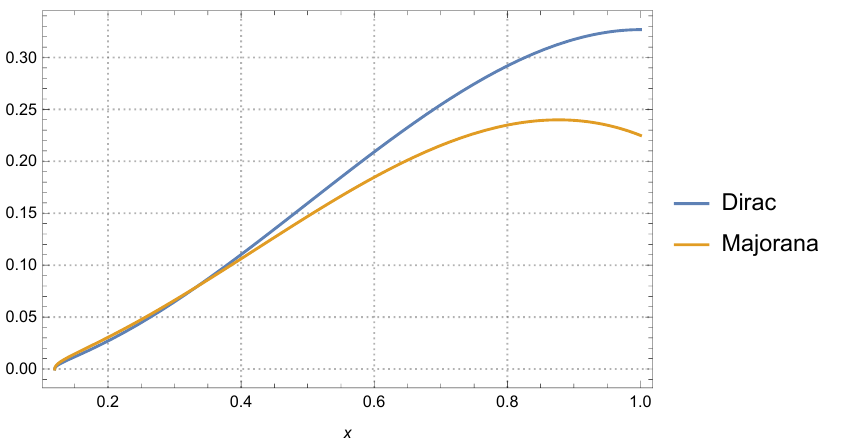
Figure 4. Energy spectrum for the V ± A theory with P T